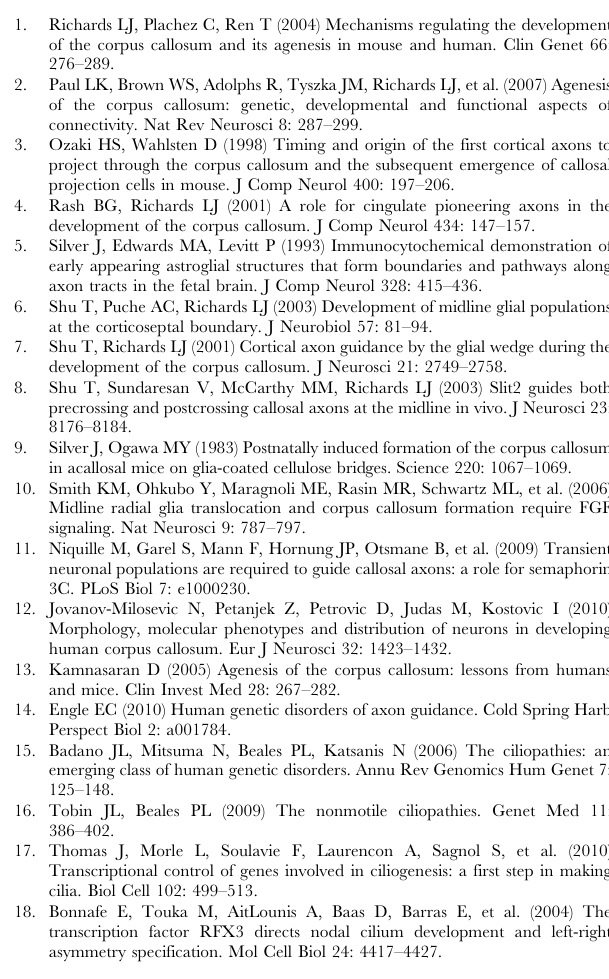
Figure S5 Localization of GABAergic interneurons in Rfx3 deficient mice. (A–B) In situ hybridization for Gad67 mRNAs on coronal CC slices of E16.5 Rfx3 deficient mice (B1–B2) in comparison with wild type (A1–A2). We observe a normal localization of Gad67 in telencephalon, and notably in the lateral CC region, of Rfx3 deficient mice (B1–B2) compared to wild type mice (A1–A2). (C–D) DAB staining for GLAST on coronal rostromedial slices from E16.5 WT (C) and Rfx3 2 / 2 (D) mice. We observe a normal localization and organization of guidepost glia of the midline zipper glia (MZG) and of the glial wedge (GW) of Rfx3 deficient mice (D) compared to wild type mice (C). Bar =1200 m m in A1, B1, Bar= 300 m m in C, D, and 150 m m in A2, B2. (TIF) Figure S6 Expression of dorsal and ventral markers in Rfx3 2 / 2 brains. In situ hybridization for Shh (A and B), Gli1 (C and D), ptc1 (E and F), Gli3 (G and H), Bmp4 (I and J) and Wnt2b (K and L) mRNAs on coronal sections from E12.5 WT (A, C, E, G, I, K, M and O) and Rfx3 2 / 2 (B, D, F, H, J, L, N and P) mice. (A to D) All dorsal midline markers are normally expressed in the Rfx3 2 / 2 embryos. (E to H) All commissural plate markers are normally expressed in the Rfx3 2 / 2 embryos. (I to P) While Shh and Gli3 were properly specified, Ptc1 receptor and Gli1 are down-regulated (black arrows) in Rfx3 2 / 2 . Interestingly, the frontier region between the septum and the cortex is reduced in